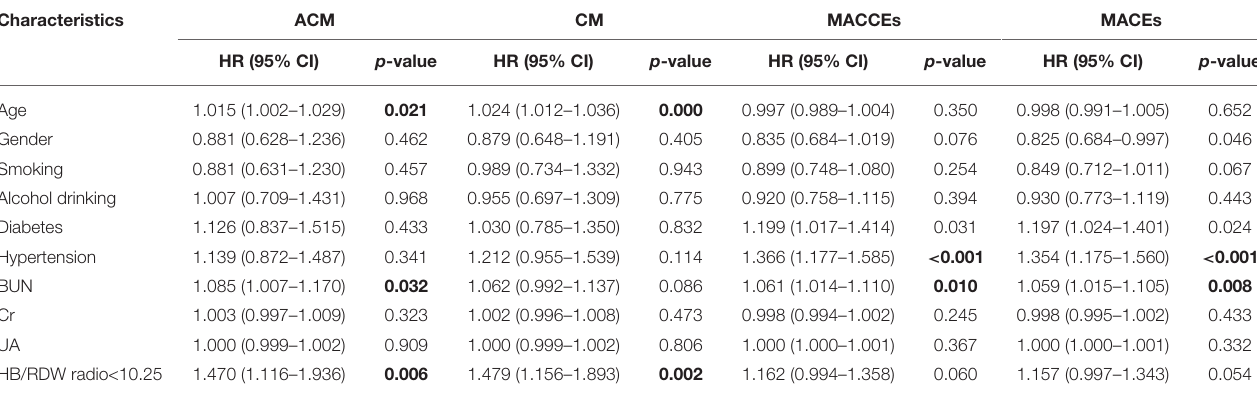
TABLE 4 | Cox proportional hazards analysis of outcomes.